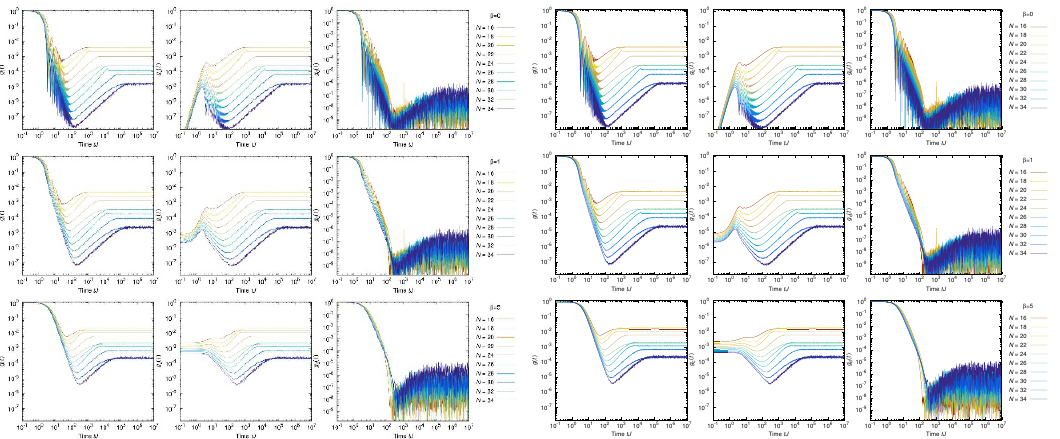
Figure 2 . Left: (cid:12)gure 12 of the original publication. Right: corrected version.